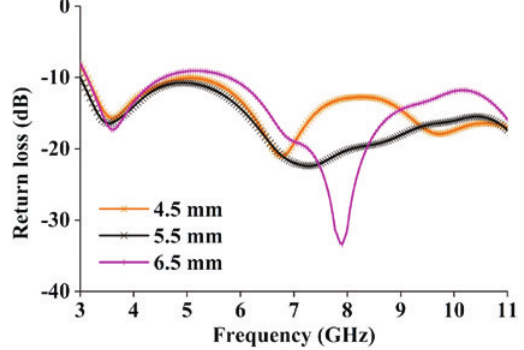
Figure 10: Measured peak gain of the proposed antenna. . L